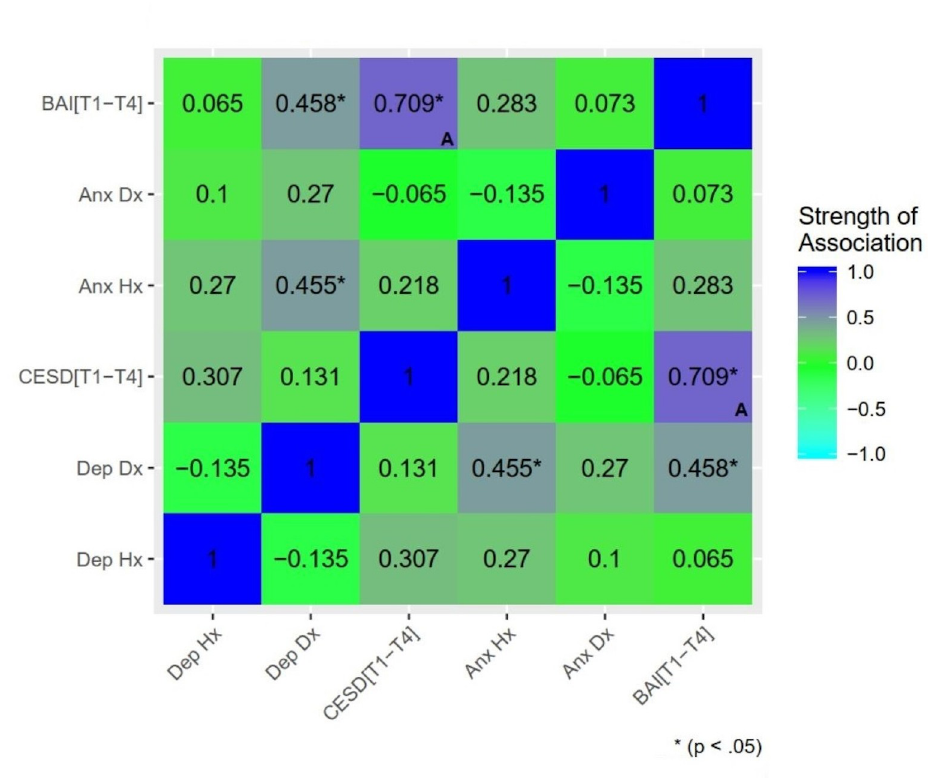
Fig 4. Associations between markers of psychopathology: Past, present, and future depression and anxiety. Dep Hx = history of depressive disorder based on the Structured Clinical Interview for DSM-IV (SCID); Dep Dx = current depressive disorder; Anx Hx = anxiety disorder history; Anx Dx = current anxiety disorder; CESD[T1-4] = estimated mean CESD score across all assessment time points (i . e . Estimated Future Depression Symptom Severity); BAI[T1-4] = estimated mean BAI score (i . e . Estimated Future Anxiety Severity) . Significance delineated at uncorrected thresholds . (A) Denotes Pearson’s correlation between a continuous-continuous pair . All other associations reported (categorical- categorical or categorical-continuous pairs) are reported using Spearman’s rank correlation .